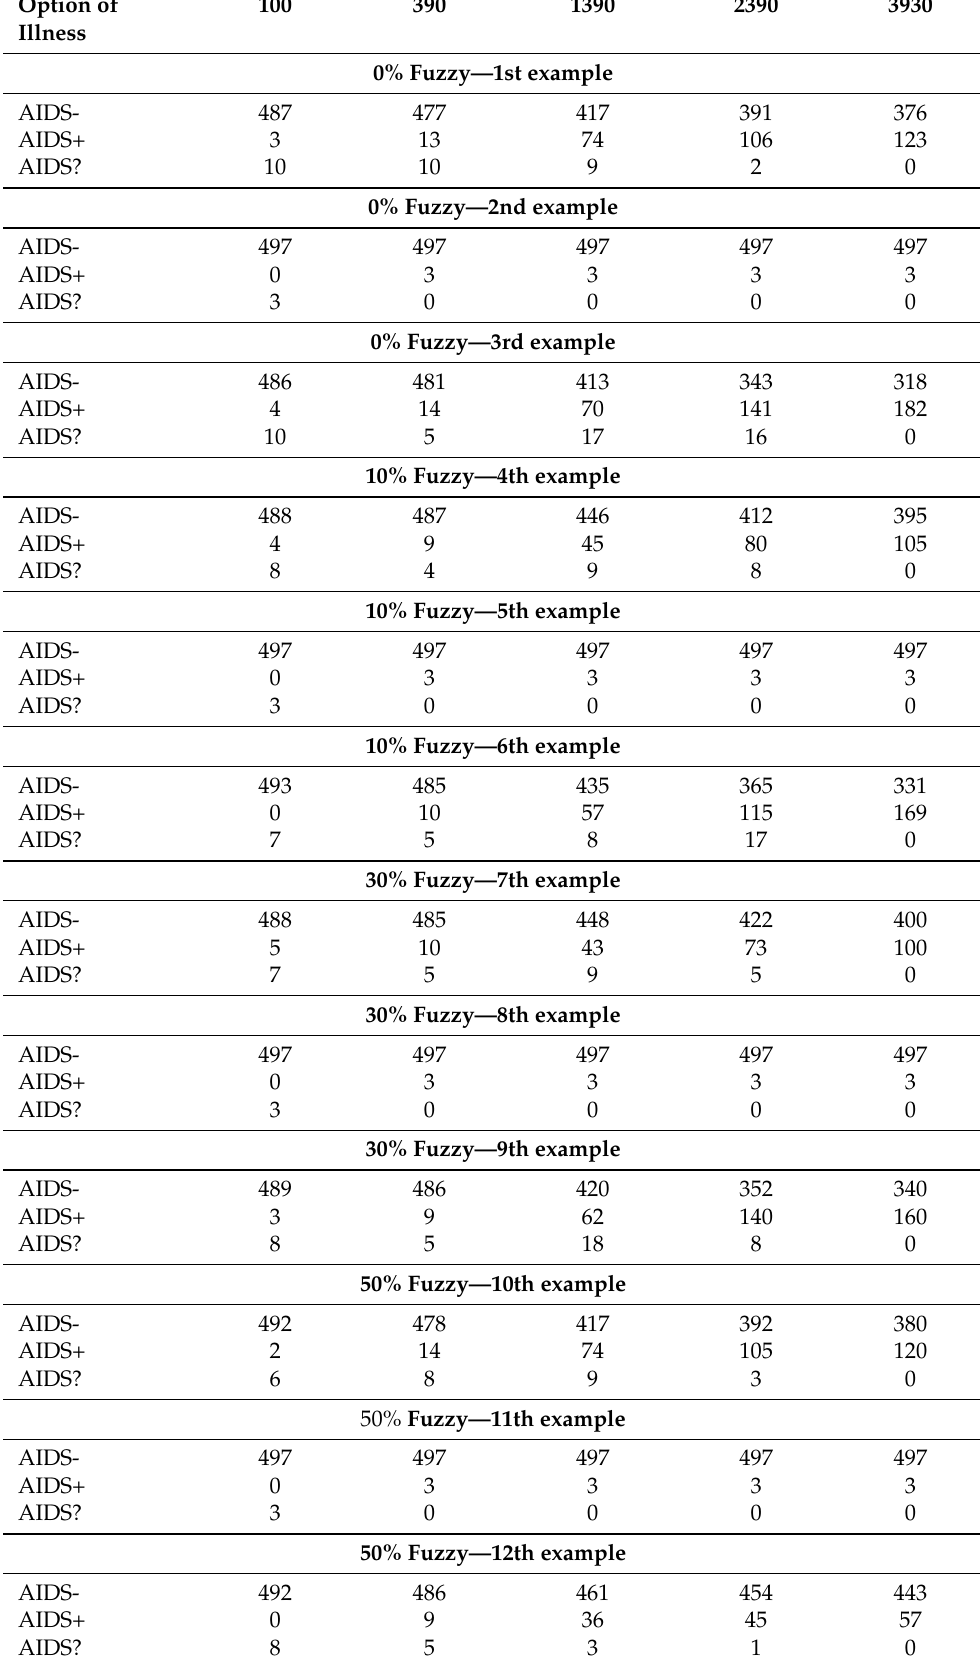
Table 7. People regarding the fourth scenario for a different number of